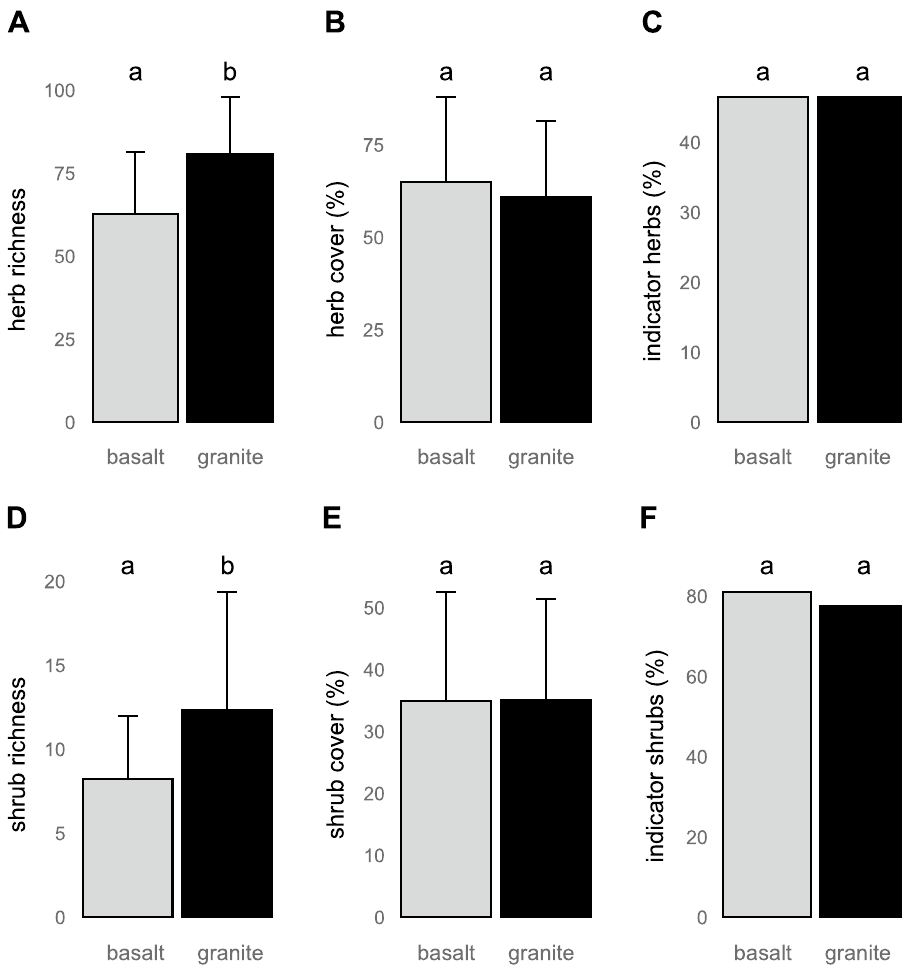
Figure 3. Richness, cover and proportion of indicator species of herbs and shrubs on granitic and basaltic bedrock. Bars show means for each type of bedrock (n = 30) and error bars are associated with standard deviation (SD). The bold letters above bars indicate significant differences between bedrocks (including marginally significant, 0.05 < p < 0.1, in normal